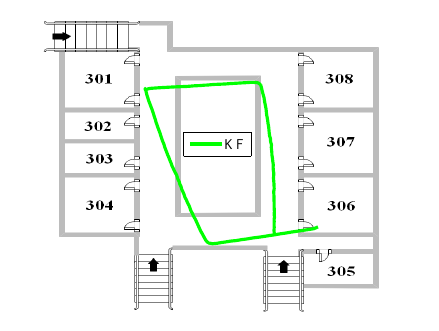
Figure 7. Positioning results for EKF.